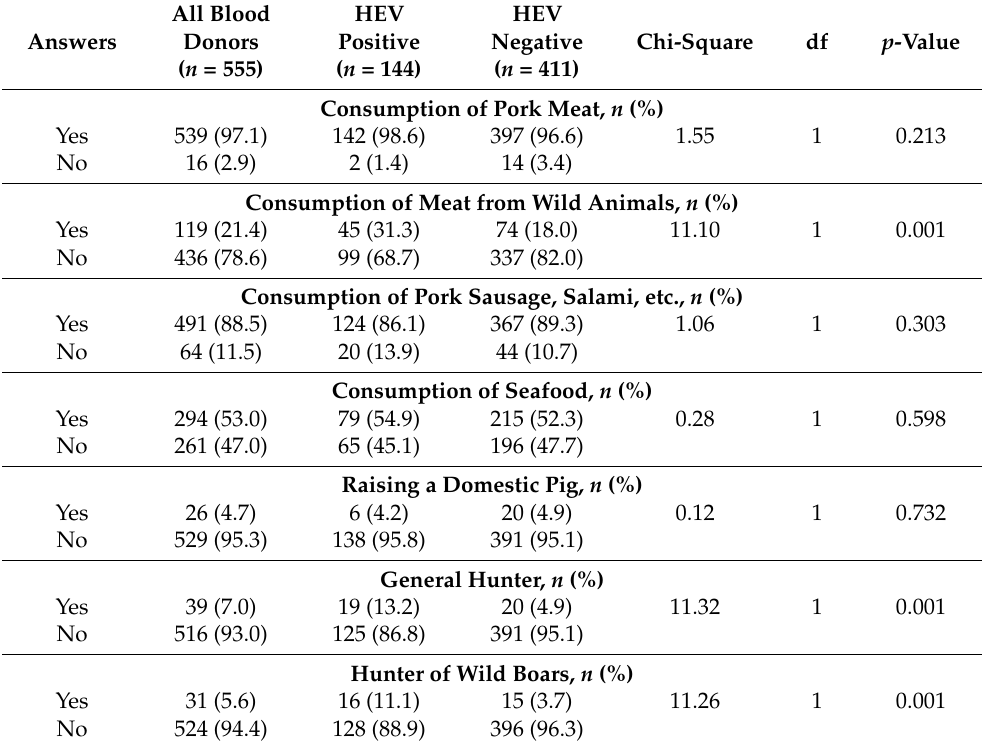
Table 4. Questionnaire analysis of HEV infection in blood donors from